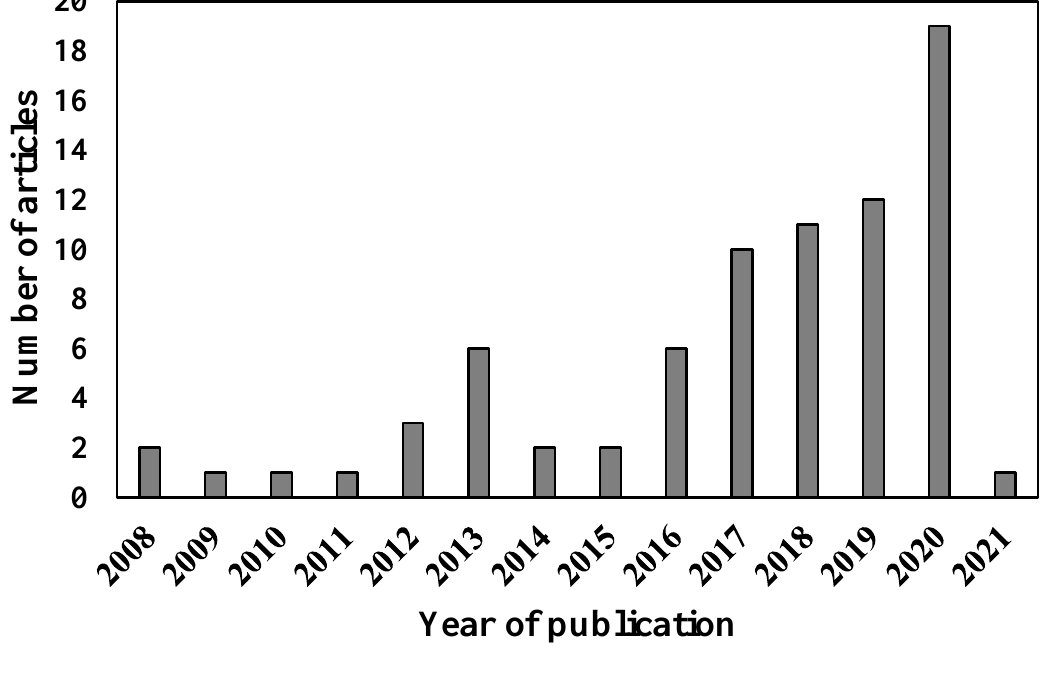
Figure 2. Systematic review by publication date.